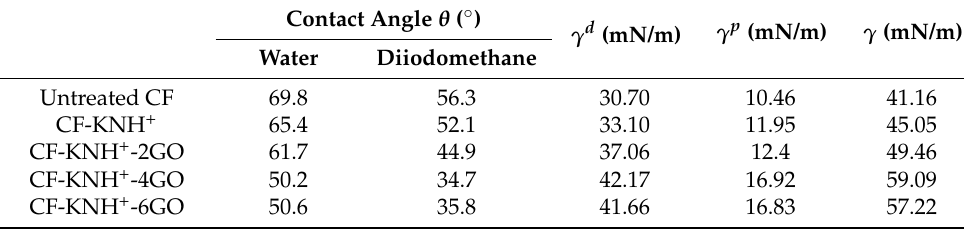
Table 2. Dynamic contact angles and surface energies of different reinforcements.